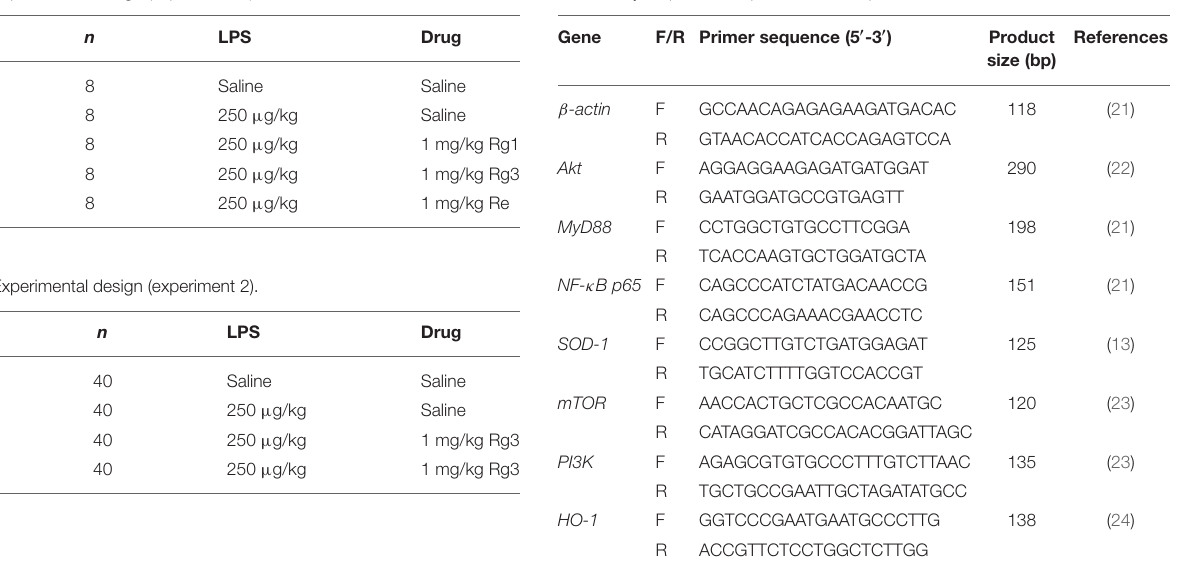
TABLE 3 | Sequences of primers for